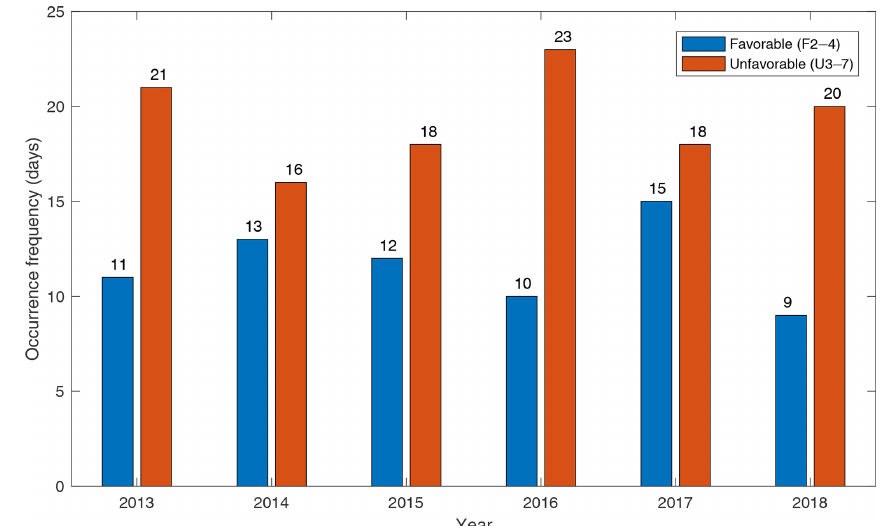
Figure 9. Occurrence frequencies of the effective favorable and unfavorable events. The effective favorable events referred to the favorable events lasting for 2–4d. The effective unfavorable events indicate the unfavorable events lasting for 3–7d. The specific number of days for favorable and unfavorable events is shown on the top of each